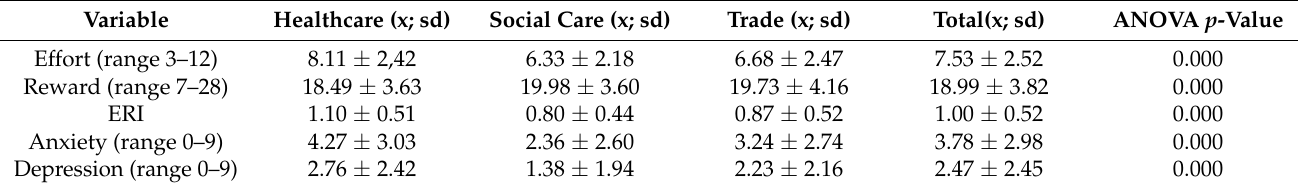
Table 2. Average values of the variables related to stress and mental health.